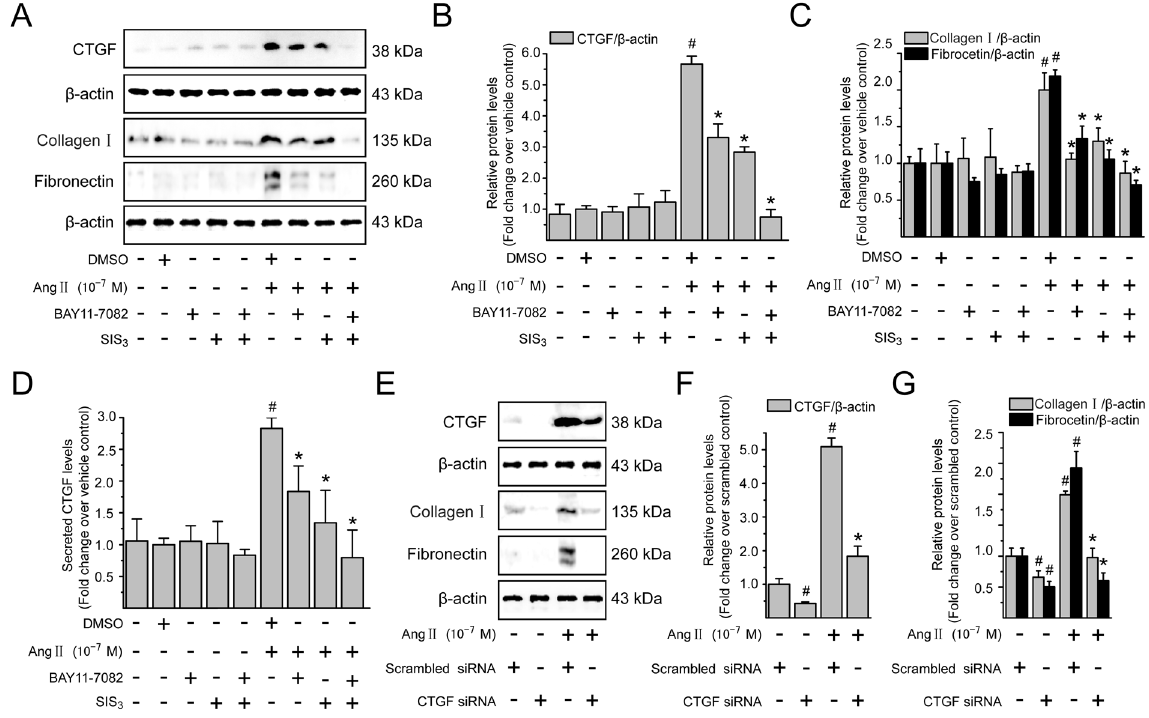
Figure 9. Ang II via NF- κ B and Smad pathways increases CTGF production and CTGF is involved in Ang II-induced ECM accumulation in LX-2 cells. Serum-starved LX-2 cells were preincubated for 0.5 h with BAY11- 7082 (a specific NF- κ B inhibitor; 10 − 6 M), or SIS3 (a specific Smad3 inhibitor, 10 − 6 M) alone or simultaneously in the presence or absence of Ang II (10 − 7 M) stimulation for 4 h (to detect CTGF) or 24 h (to detect type I collagen and fibronectin). Whole cell lysates were immunoblotted with antibodies against CTGF, type I collagen and fibronectin, respectively. β -Actin level served as a control for equal protein loading. ( A ) Representative immunoblot bands are shown for the indicated antibodies. ( B,C ) The histogram represents results of the densitometric scans for the protein bands of CTGF, type I collagen and fibronectin after normalization with β - actin. ( D ) CTGF concentrations in the cell supernatants were determined by ELISA, and the value in the vehicle control group was defined as 1.0. ( E ) Serum-starved LX-2 cells transiently transfected with scrambled siRNA or CTGF siRNA were treated with Ang II (10 − 7 M) for 4 h (to detect CTGF) or 24 h (to detect type I collagen and fibronectin), respectively. After treatment, aliquots of whole cell lysates were subjected to immunoblotting with specific antibodies as indicated. β -Actin was used as an internal control. ( E ) The experiments were repeated thrice with similar results and representative immunoblot bands for CTGF, type I collagen and fibronectin are shown. ( F,G ) Fold-change in relative protein level of each protein is shown after normalizing with β -actin. All data are presented as mean ± SD of 3 independent experiments. # P < 0.05 versus vehicle- or scrambled siRNA- treated control cells; * P < 0.05 versus Ang II- or Ang II + scrambled siRNA-treated